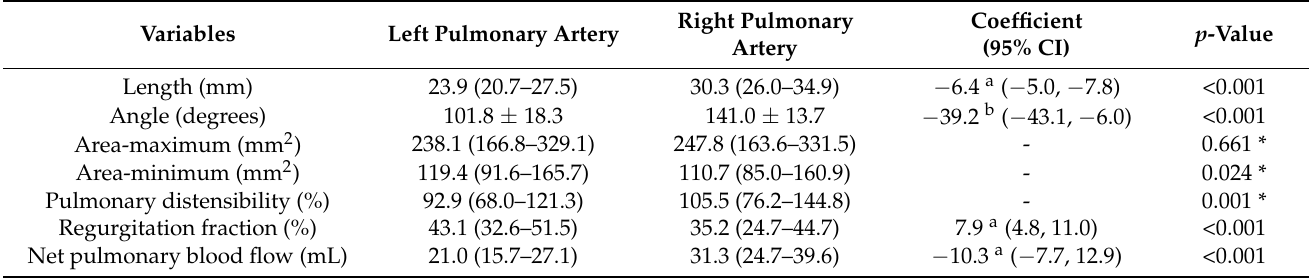
Table 3. Parameters of the left and right pulmonary